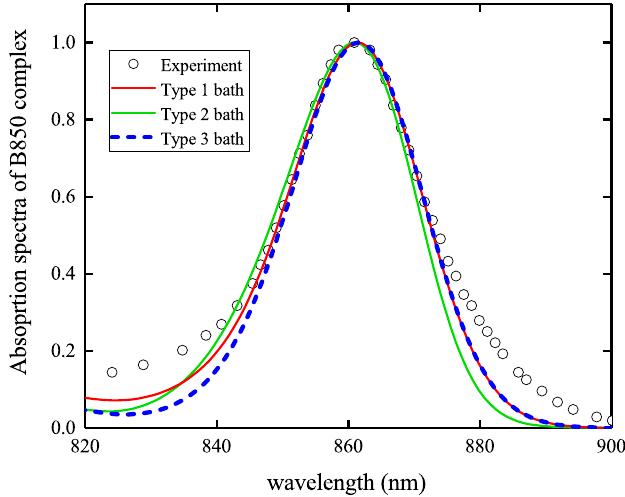
Figure 2. Calculated absorption spectra of the B850 complex with different phonon baths. Type 1 bath is characterized by 48 effective modes [72], type 2 bath is represented by a Drude spectral density, and type 3 bath is composed of a set of linear dispersed phonon modes. The experimental data are shown by open circles